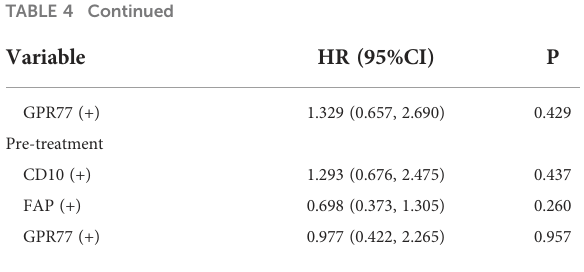
TABLE 4 Univariable analysis for overall